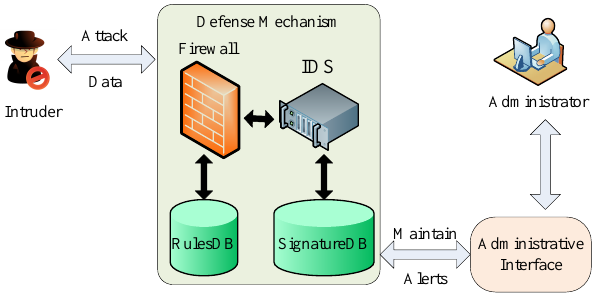
Figure 2. Defense Scenario II with firewall and the Intrusion Detection System (IDS).